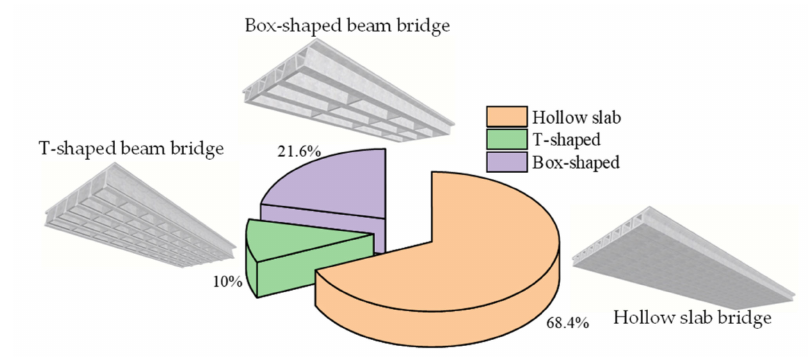
Figure 6. Percentage of the amount of bridges of each type in Hebei